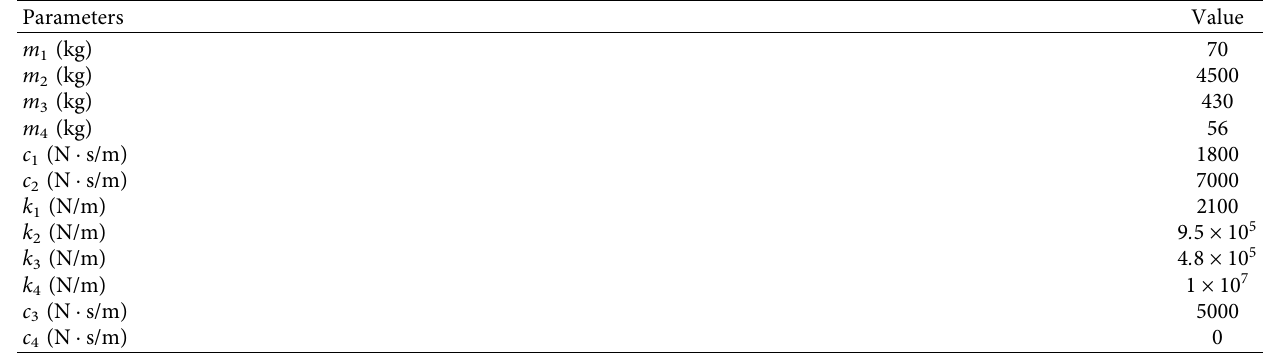
Table 3: Parameters for the vehicle and manhole